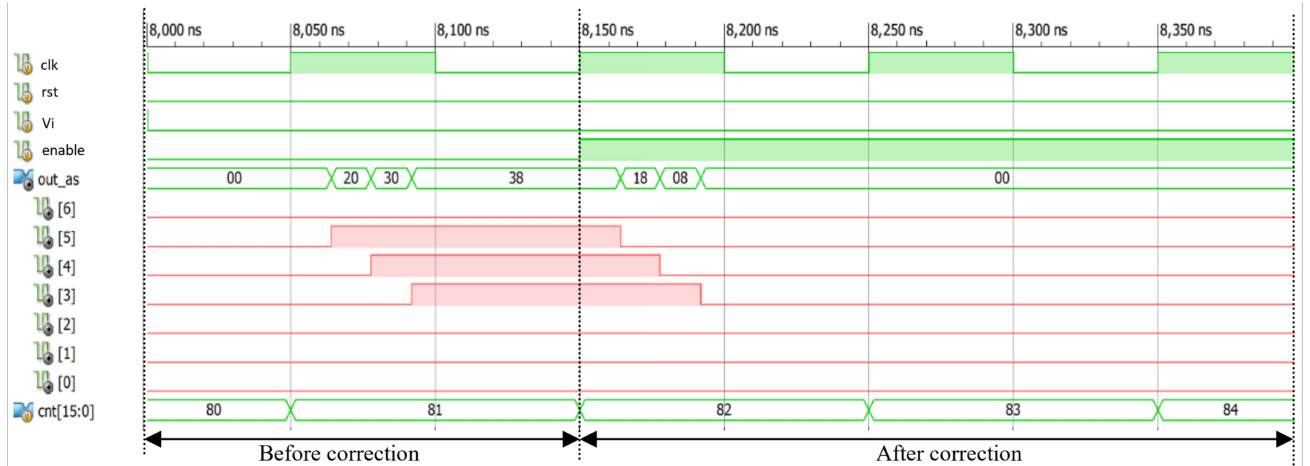
Figure 11. Output result for detection with automatic clock